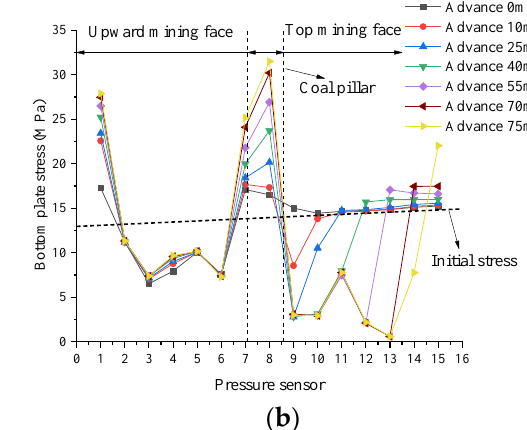
( b ) Figure 10. Variation of floor stress during upper coal mining. ( a ) Overlying rock displacement of upper coal mining; ( b ) stress variation diagram of bottom plate. With the advance of the working face, the basic roof of the upper coal seam with a large dip angle broke and collapsed, and the overlying strata bent and sunk. Due to the